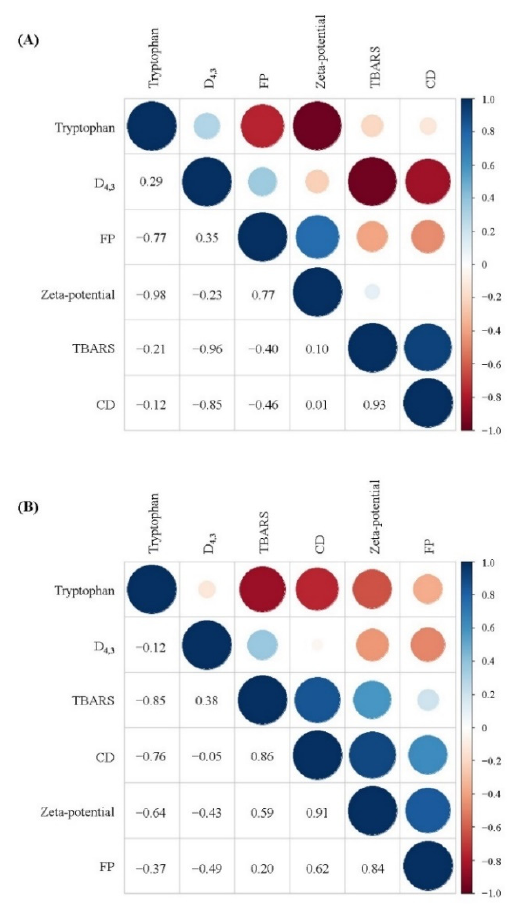
Figure 8. Correlation analysis between the physical and oxidative stability of filled hydrogels containing different CaCl 2 levels for a storage time of 0 days ( A ) and 10 days ( B